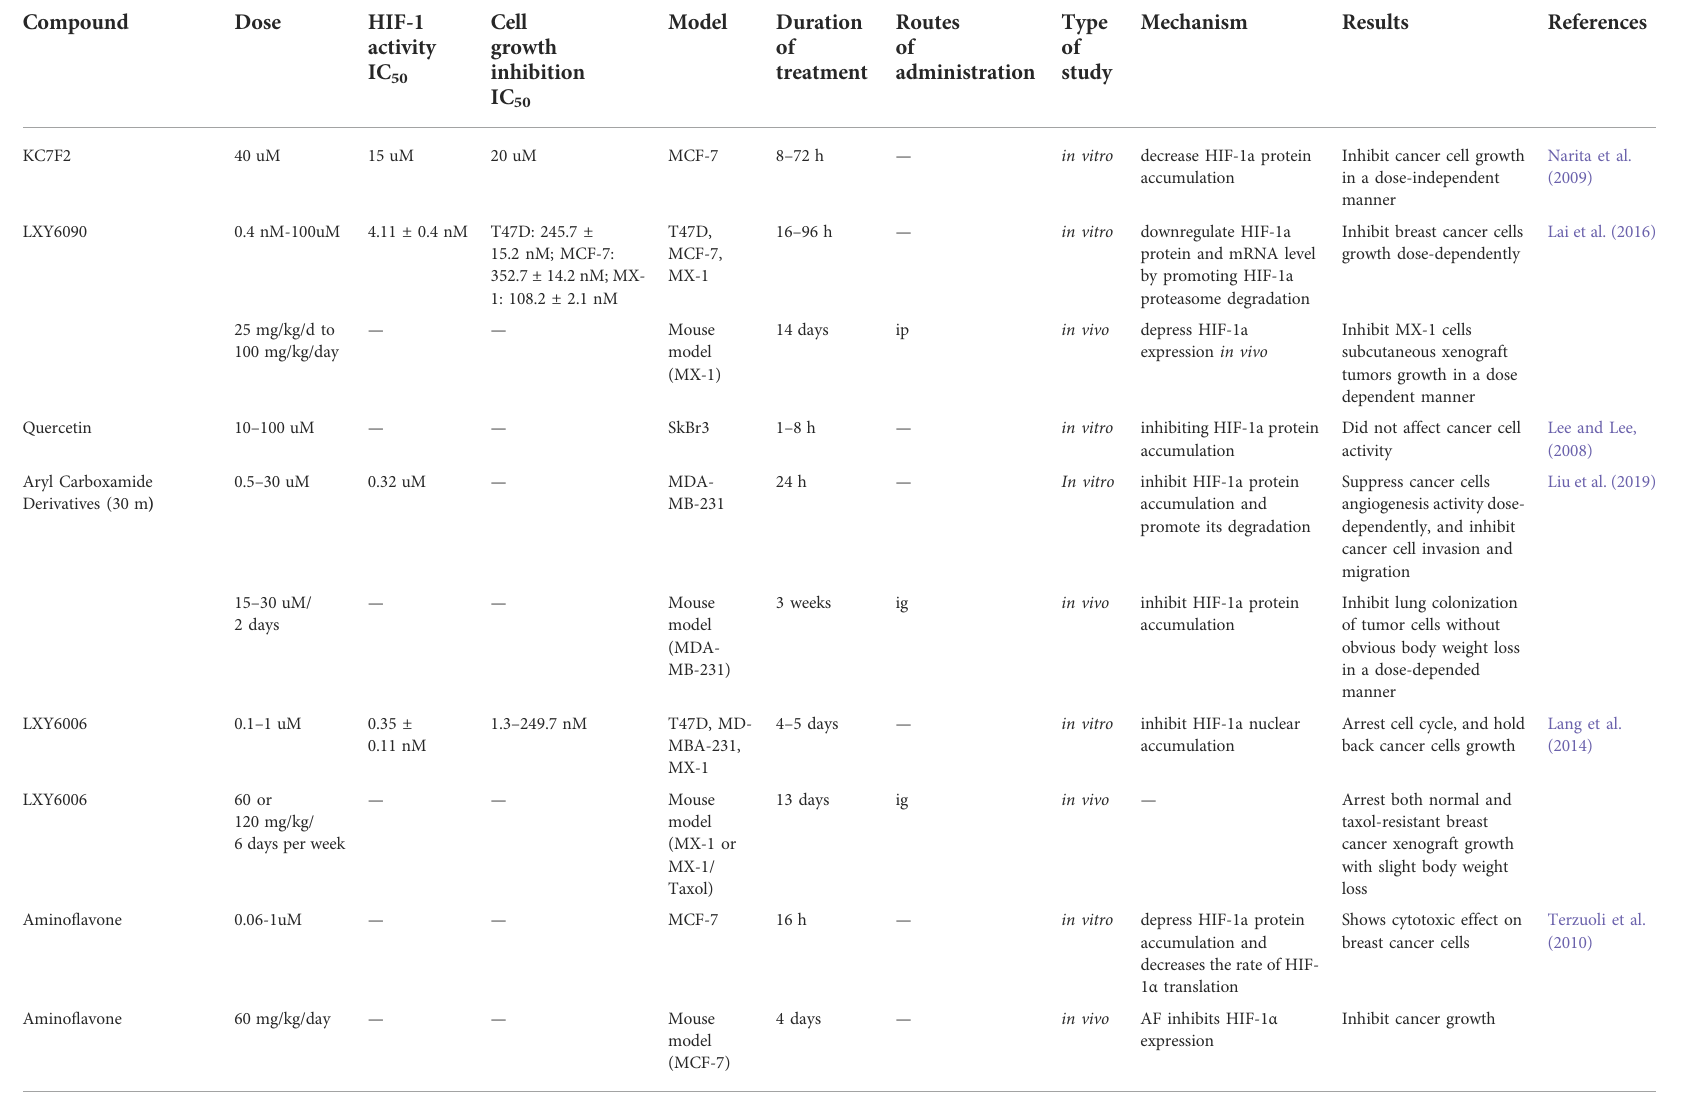
TABLE 2 HIF-1 α inhibitors under investigation in